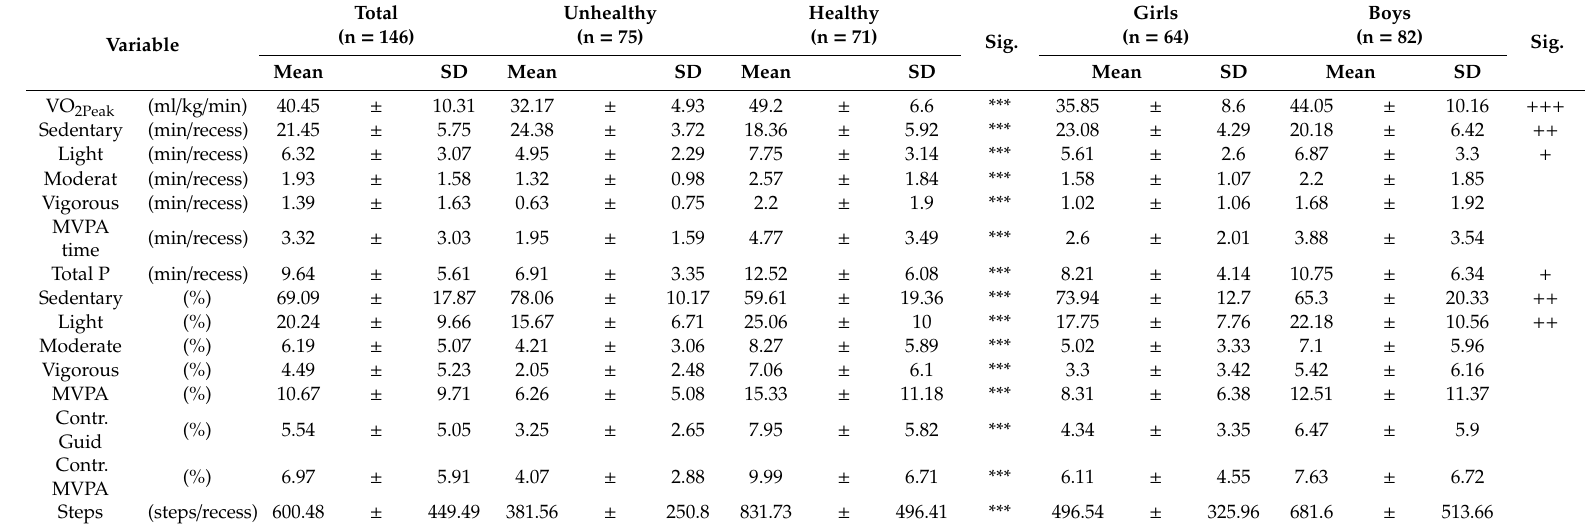
Table 2. Daily physical activity levels during recess between boys and girls split by unhealthy and healthy VO 2Peak